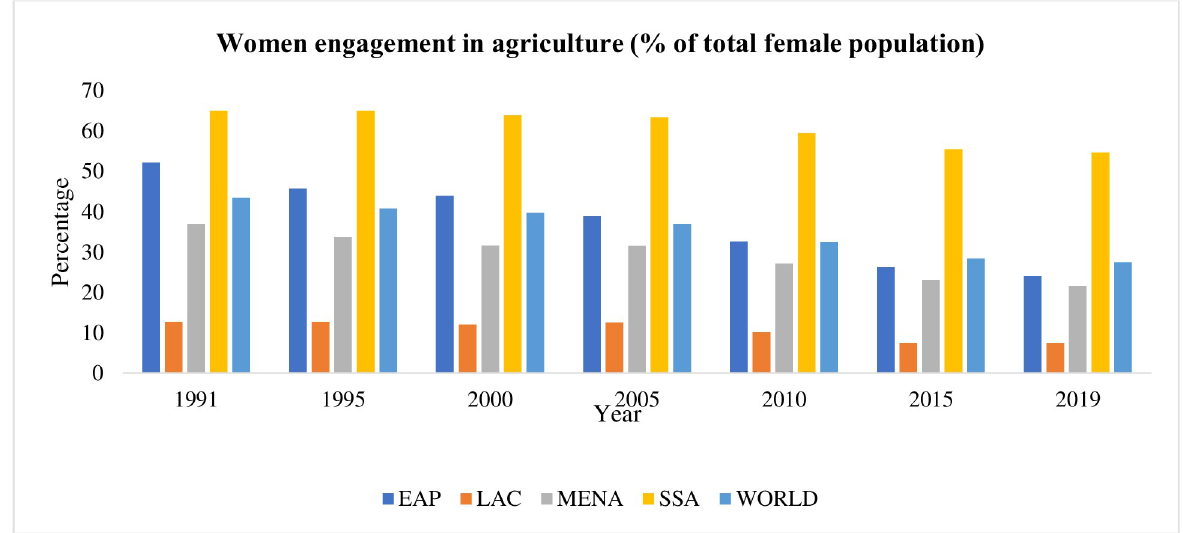
Fig 1. Female employment in agriculture (% of total female population) in developing regions. Note: EAP- East Asia and the Pacific. LAC-Latin America the Caribbean, SSA-sub-Saharan Africa. MENA-Middle East and North Africa. Source: Researchers’ Compilation, using World Bank (2019)